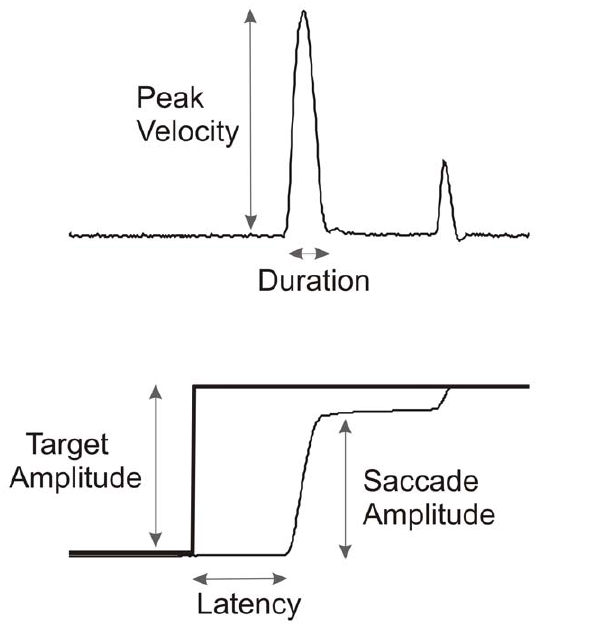
Figure 2. Saccadic eye movement parameters.